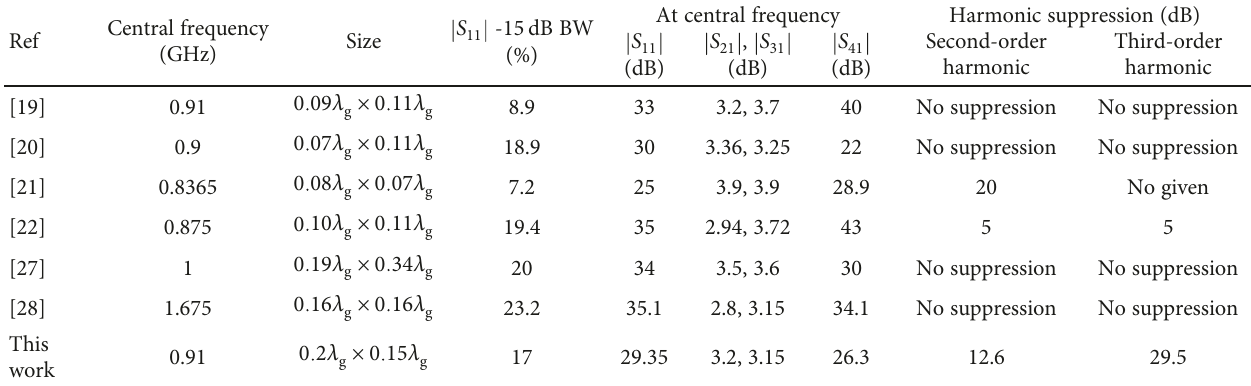
Figure 16: Simulated S -parameters of the conventional branch-line coupler. Table 4: Performance comparisons of branch-line